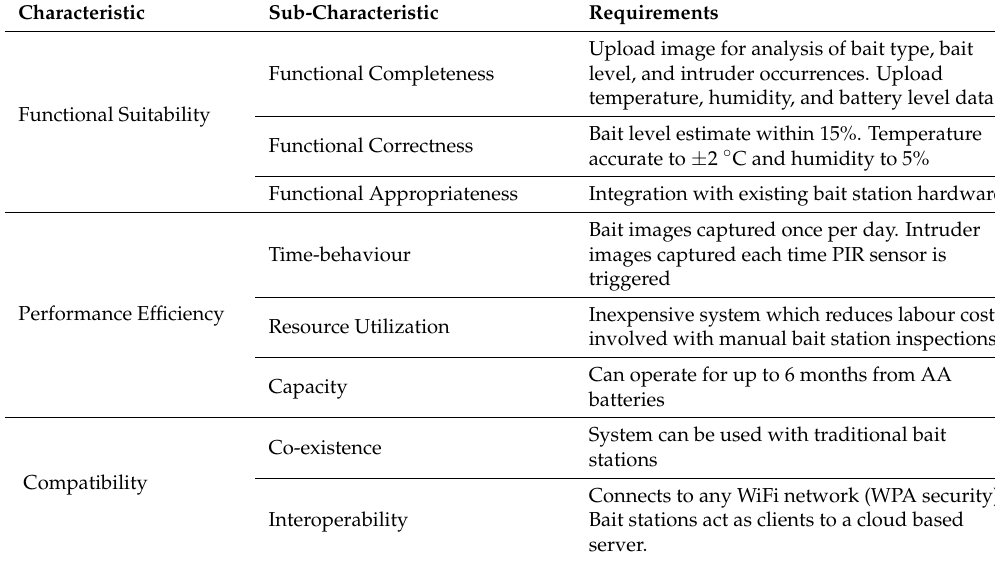
Table 1. Product Quality